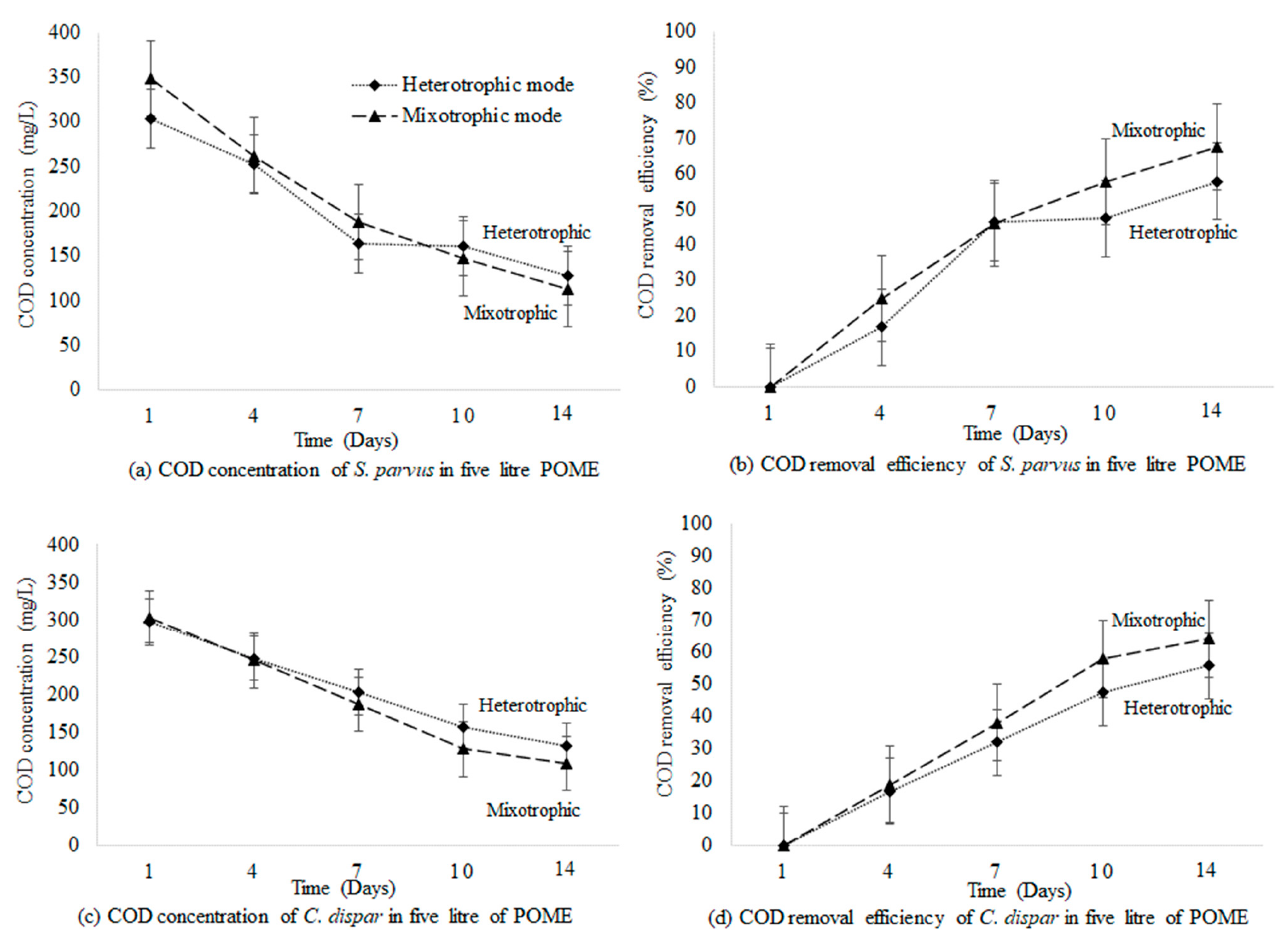
Figure 5. COD concentration and removal efficiency of ( a , b ) S. parvus and ( c , d ) C. dispar throughout the 14-day period of cultivation with 5 L of POME.